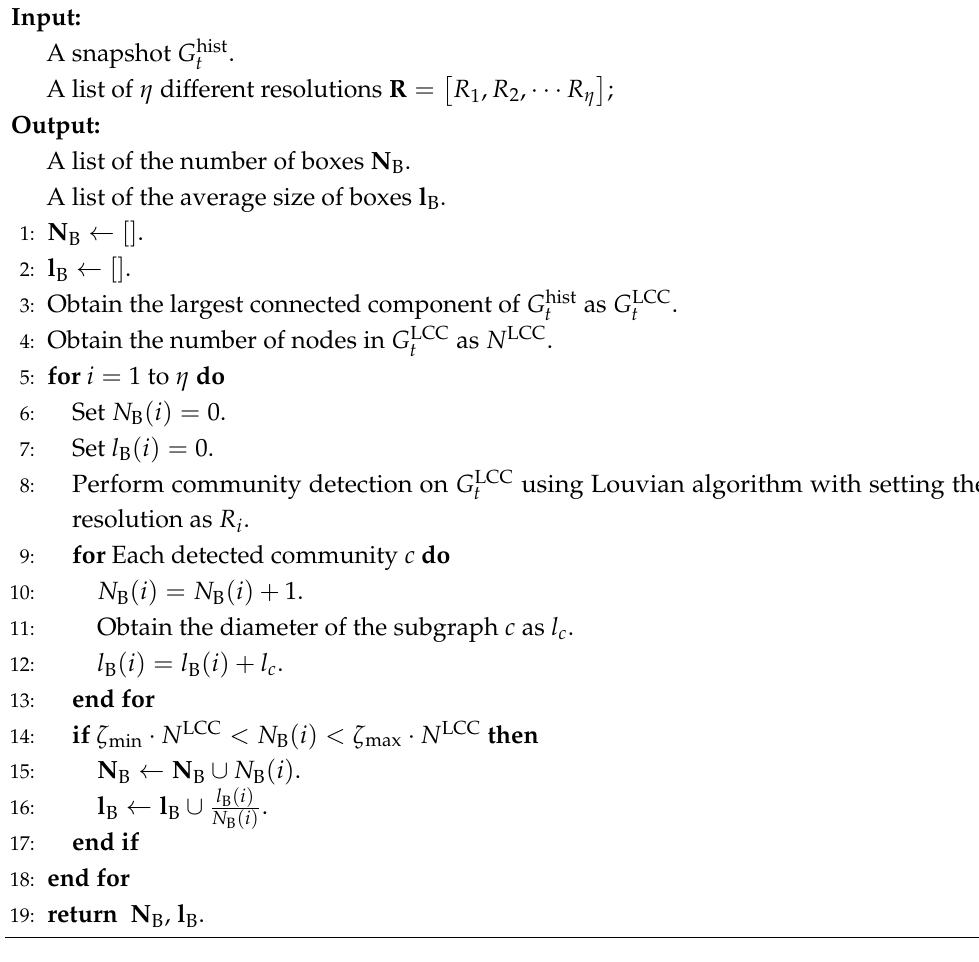
Algorithm A1 Giudicianni’s community-structure-based box-covering